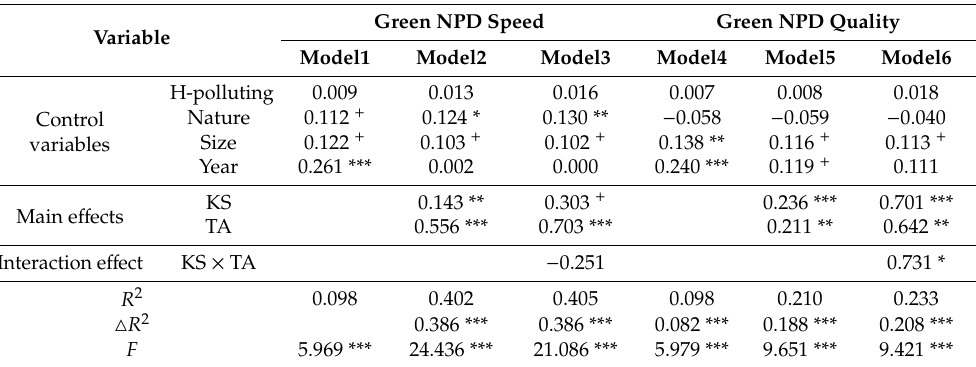
Table 8. Test results of moderating e ff